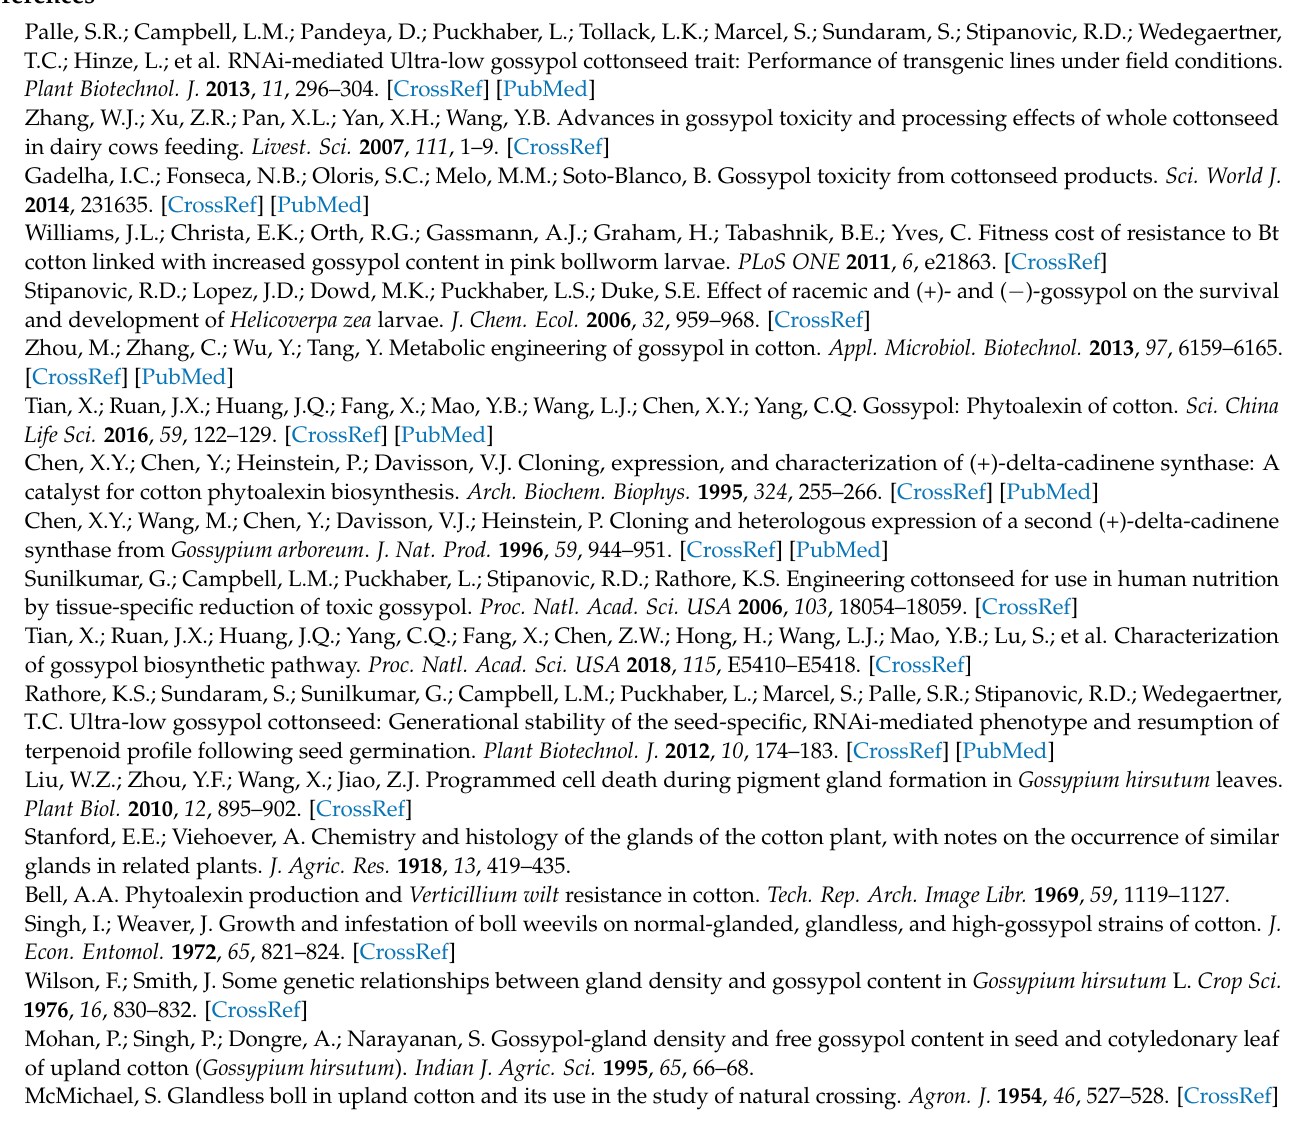
and V. vinifera. Table S8 Predicted TFBS information. Table S9 Information of predicted miRNA targets of 6 NAC